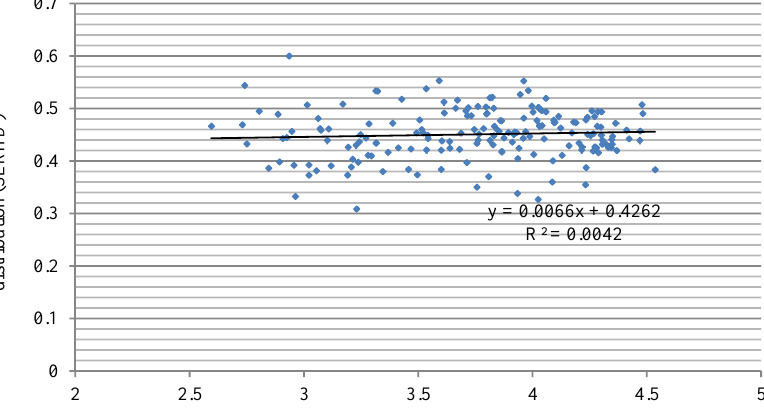
Figure 4. Linear regression for link "the absolute size of consumer spending — a measure of diversity of consumer spending (within-group entropy for SLRHD)"